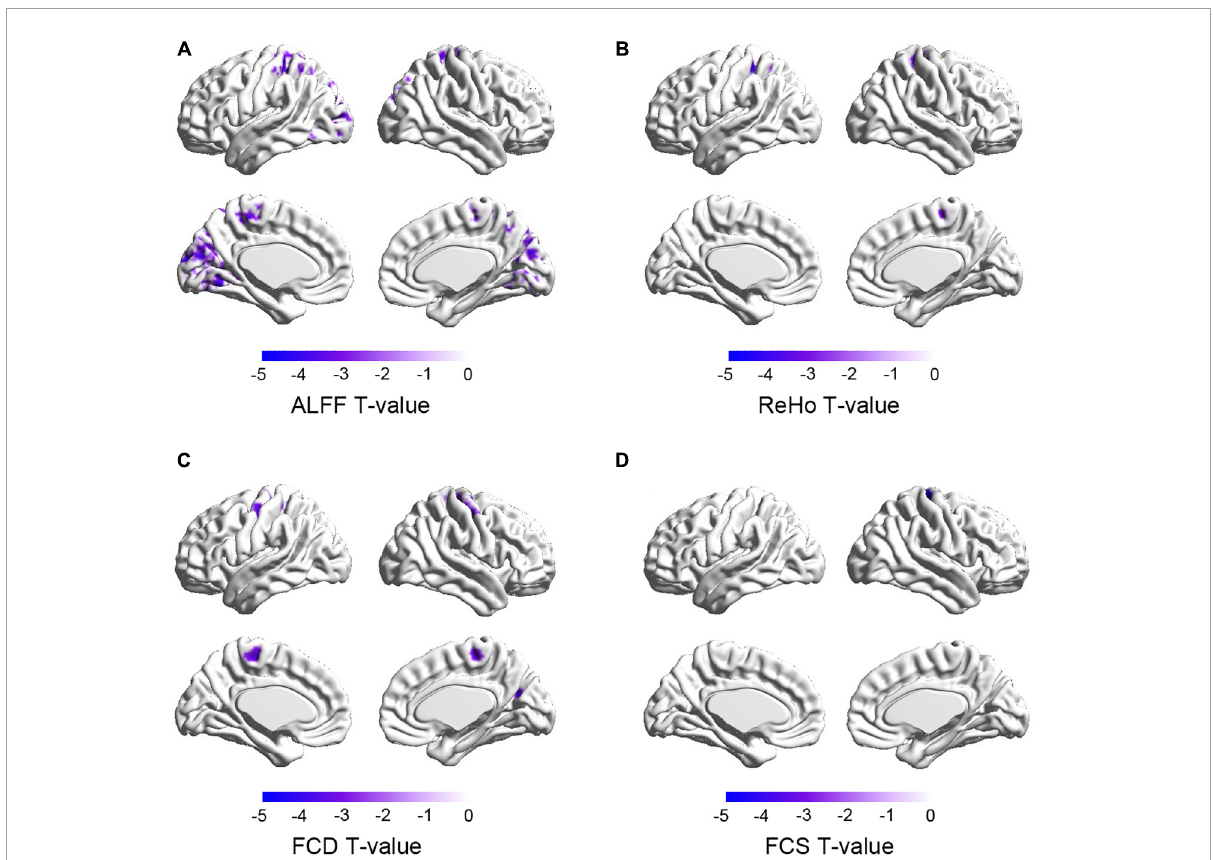
FIGURE3 (A–D) Functional properties of brain areas correlated with academic achievement in basic biomedical sciences. The color demonstrates the T -values of the correlation analyses. ReHo, regional homogeneity; ALFF, amplitude of low frequency fluctuation; FCD, functional connectivity density; FCS, functional connectivity